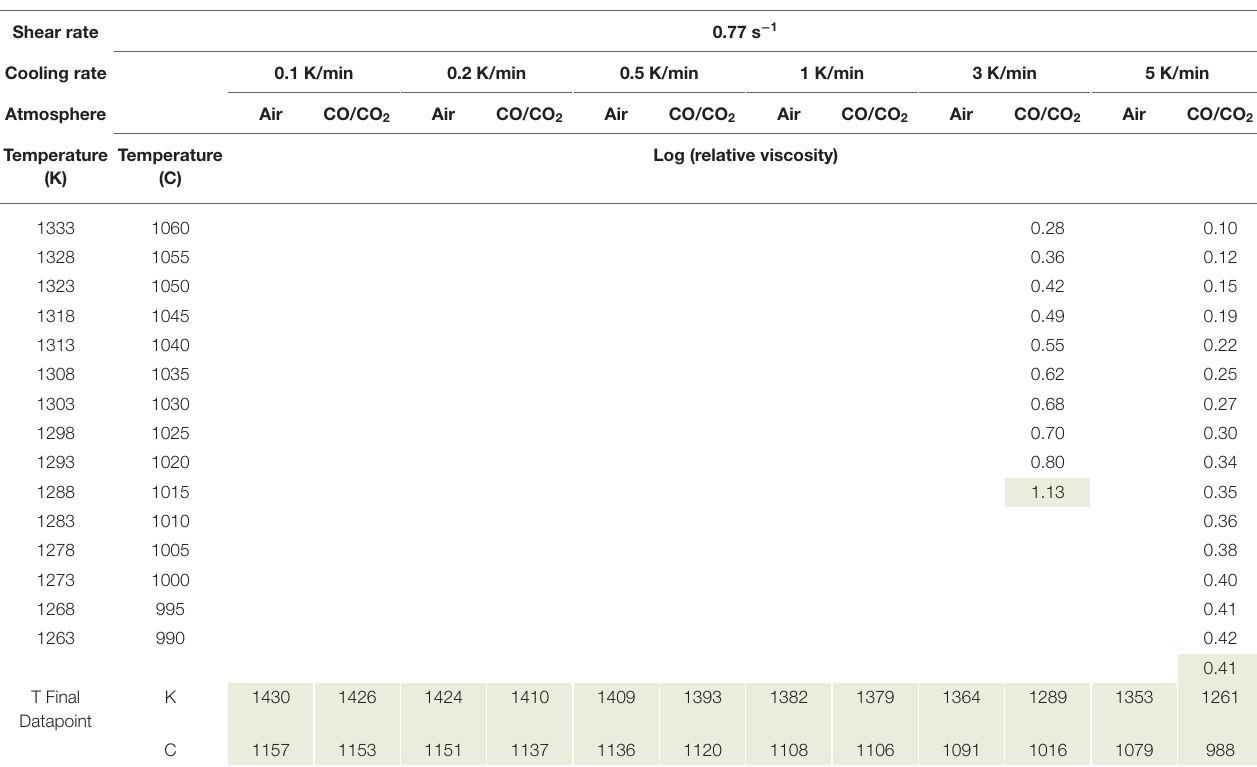
Frontiers in Earth Science |